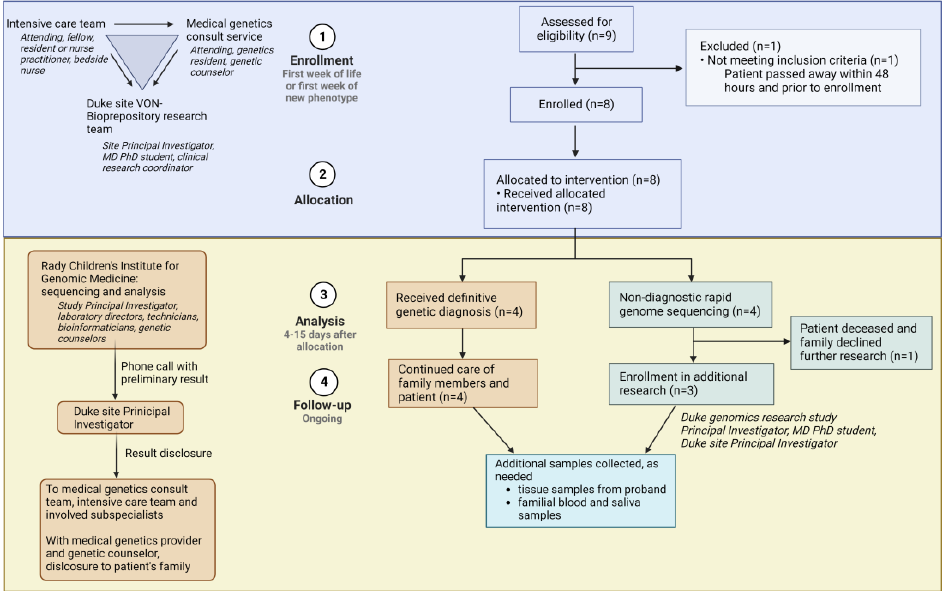
Figure 2. Study team and design flowchart showing overall study enrollment, as well as coordination, communication, and interactions among multiple medical providers and research teams across two institutions. Image created with Biorender.com accessed on 14 November 2022. VON: Vermont Oxford Network